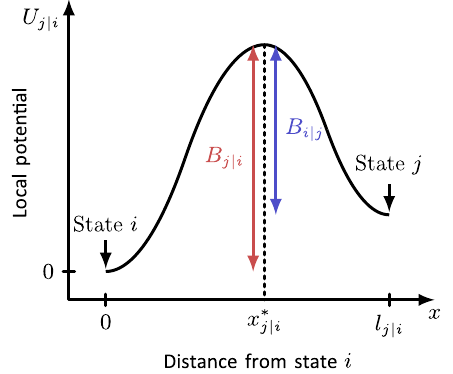
FIG. 5. Local potential with local equilibration. Local potential R x U x Þ ¼ − 0 F j j i ð y Þ dy between one pair of nodes i and j . The j j i ð of the local two states are separated by a single maximum at x (cid:3) j j i x (cid:3) potential characterized by F Þ ¼ 0 , while satisfying j j i ð j j i x Þ < 0 if x < x (cid:3) x Þ > 0 if x > x (cid:3) F and F . Local equili- j j i ð j j i ð j j i j j i bration occurs if the local free-energy barriers are high, meaning ≫ k ≫ k T and B T that B j j i B i j j B